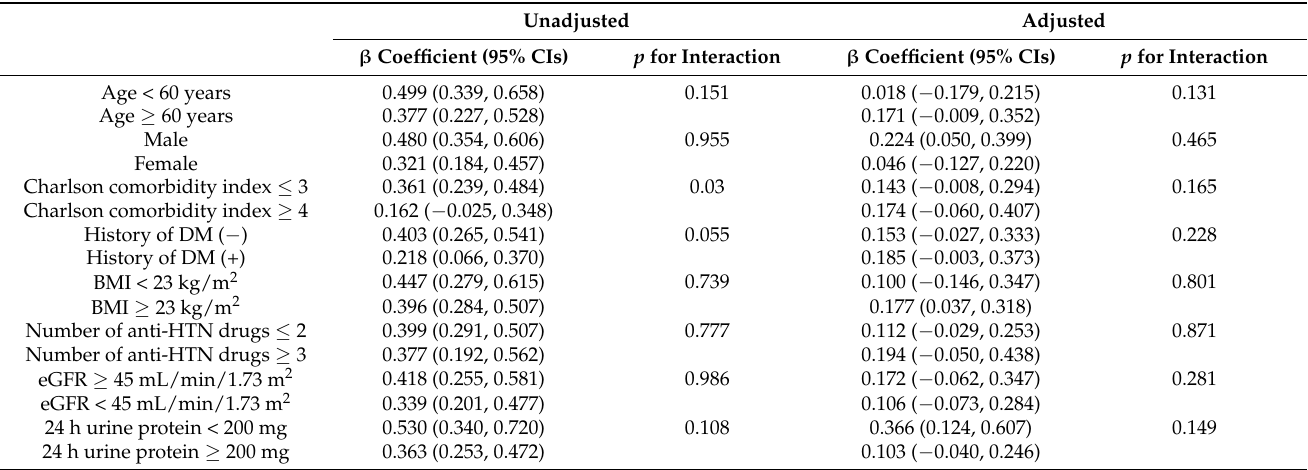
Table 4. Multivariate linear regression analyses of serum OPG level (per pmol/L) for ARV of SBP in various subgroups.